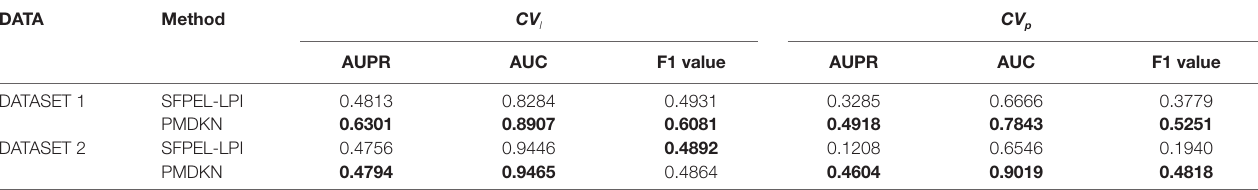
TABLe 2 | Comparison of predicted performance of new lncRNAs and new proteins based on DATASET1 and DATASET2.